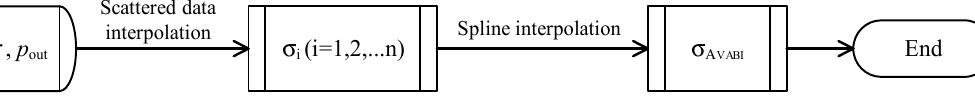
Figure 7. The acquisition of σ using the calibration database.